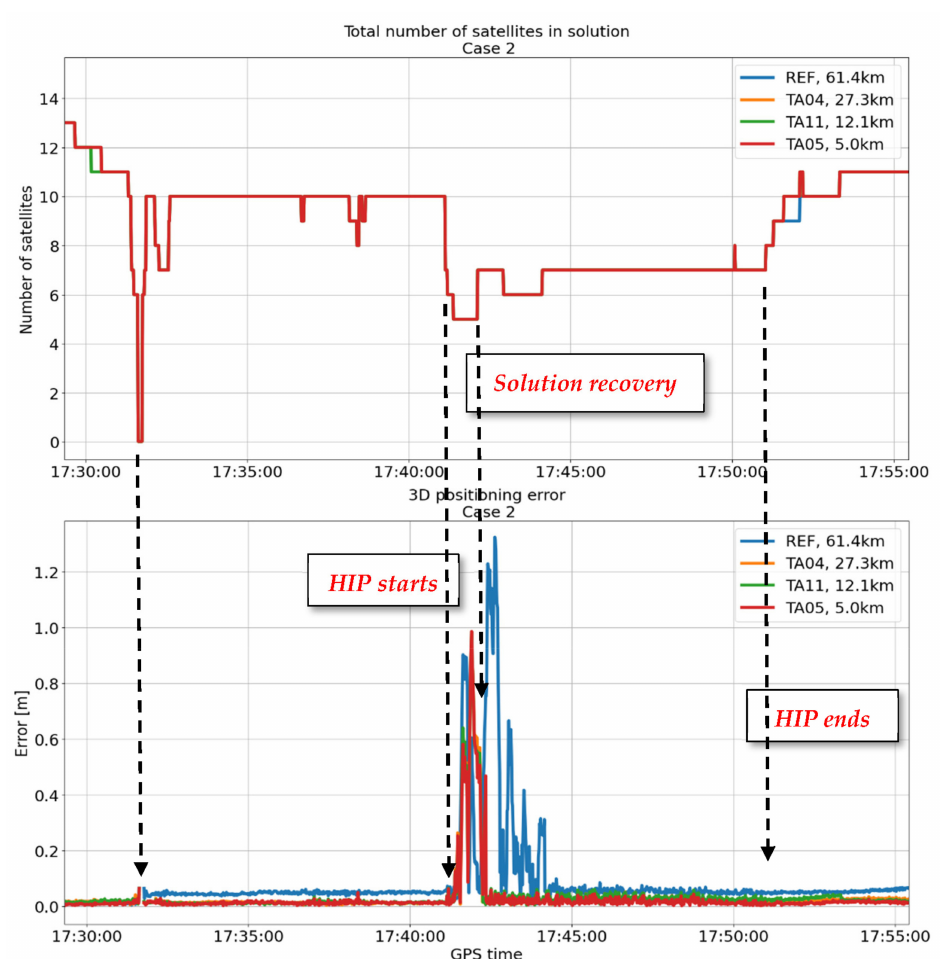
Figure 12. Number of satellites ( top ) and 3D positioning error ( bottom ) of the four baselines in Case 2. All solutions are based on dual-frequency GPS and Galileo data.